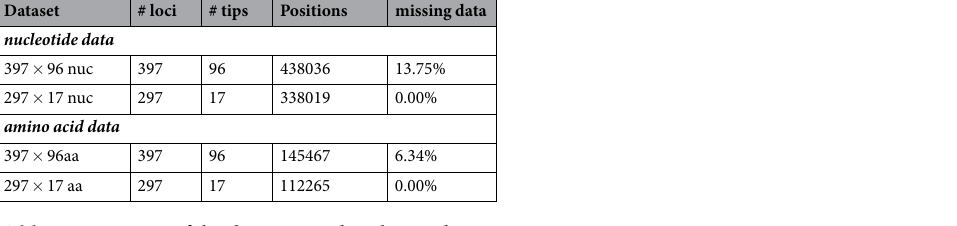
Table 1. Summary of the datasets used in this